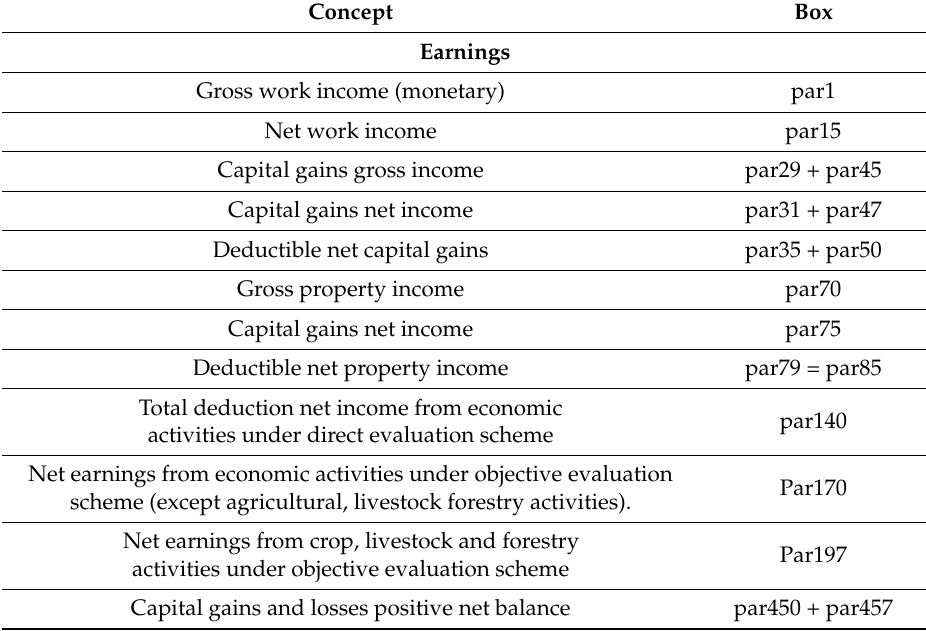
Table 1. Independent variables of the neural network model.